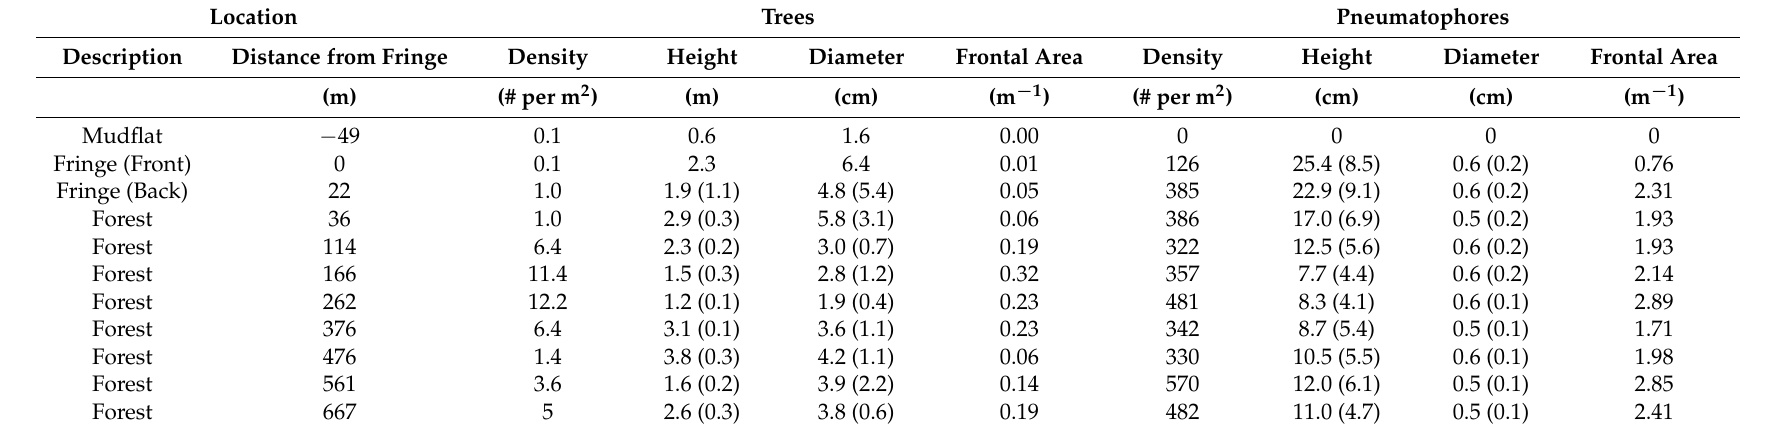
Table 3. The Firth of Thames vegetation survey summary. The values given are averages with the standard deviation where appropriate.